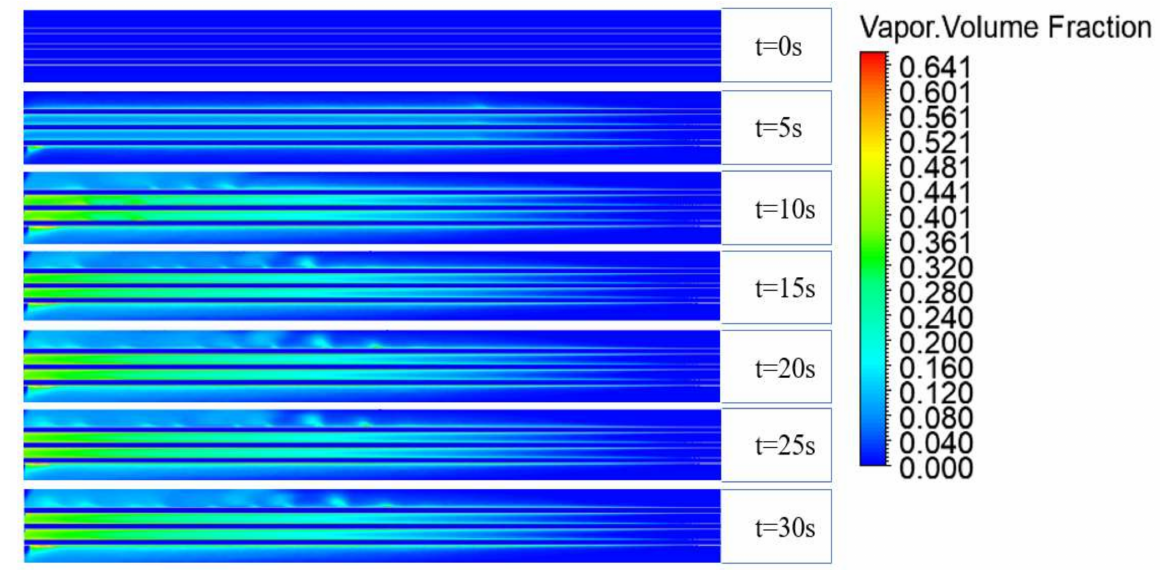
Figure 10. CFD simulation results in R23 gas-phase fraction cloud